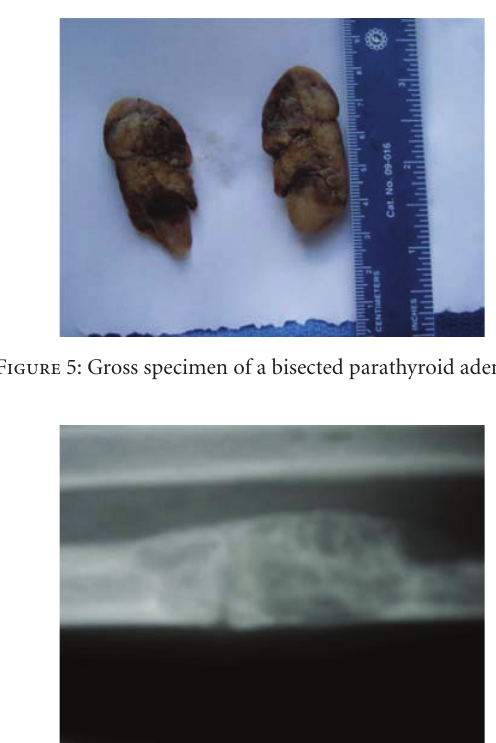
Figure 6: A lateral X-ray of the right ulna showing healing of the pathologic fracture in progress (8 weeks after